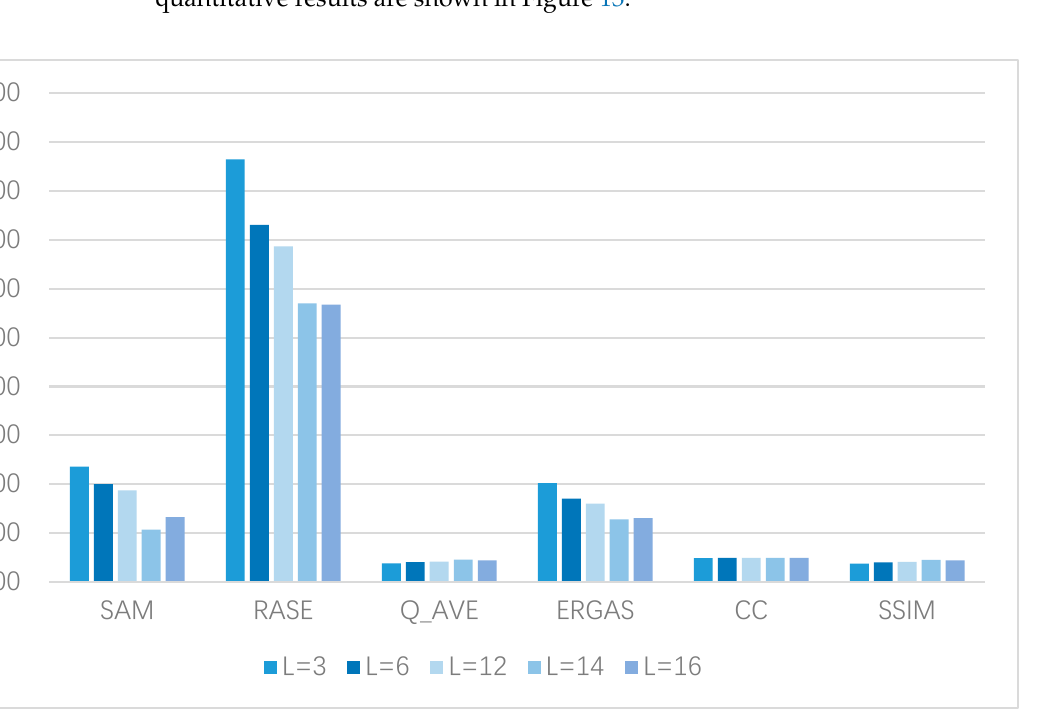
Figure 13. Figure of quantitative assessment results of different coding network parameters. The objective evaluation index shows that increasing the depth of the dense coding network can improve the performance of the network, and the performance of the network can be significantly improved when the depth of the coding network increases. The reason lies in the increase in network depth and width, which enhances the ability of